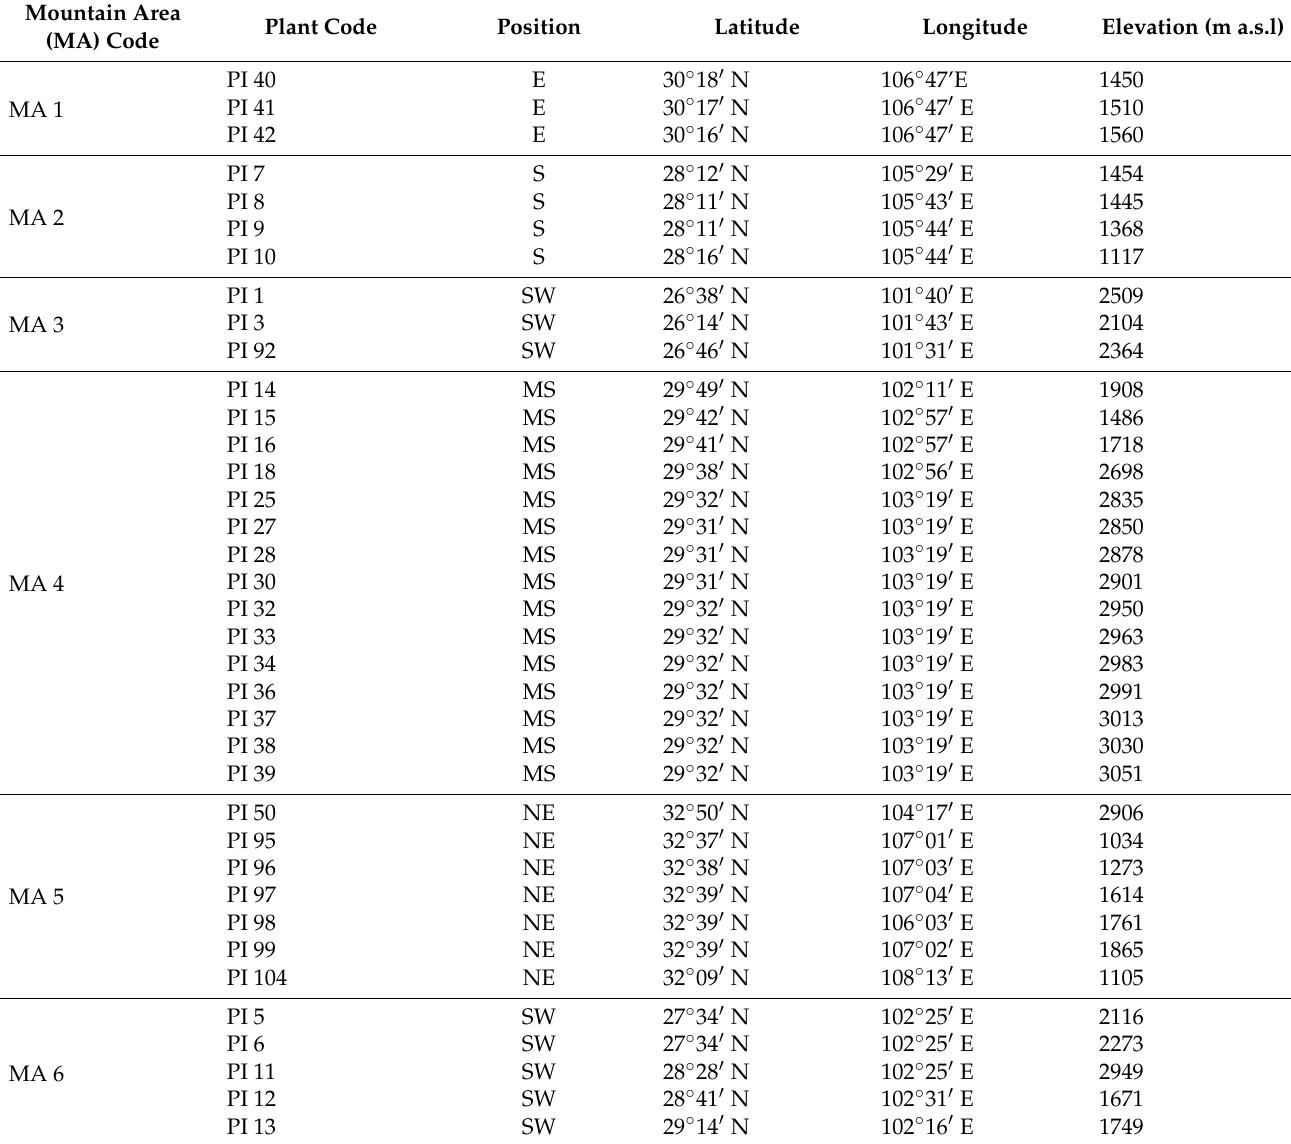
Table 1. Sichuan Province locations (MAs) and plant codes of F. nilgerrensis used in this study. (Position: E, East; S, South; SW, South-West; NE, North-East; MS, Mid-South. Latitude, longitude, and altitude of the locations are indicated). Mountain